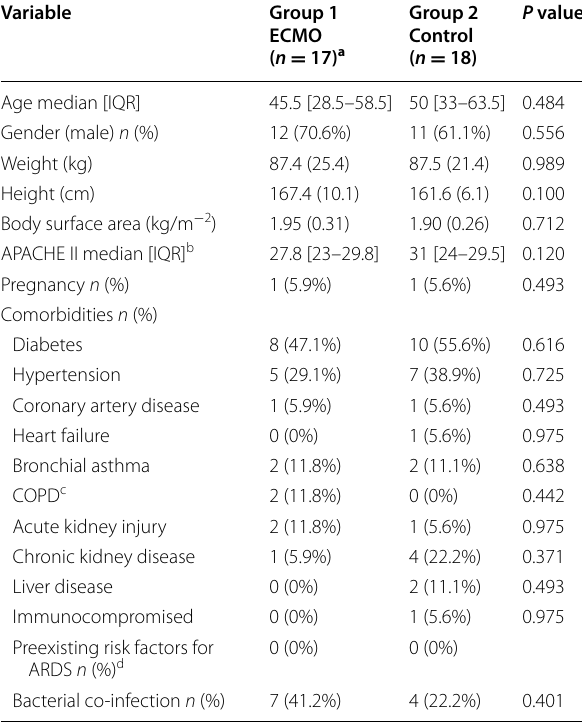
Table 1 Patients